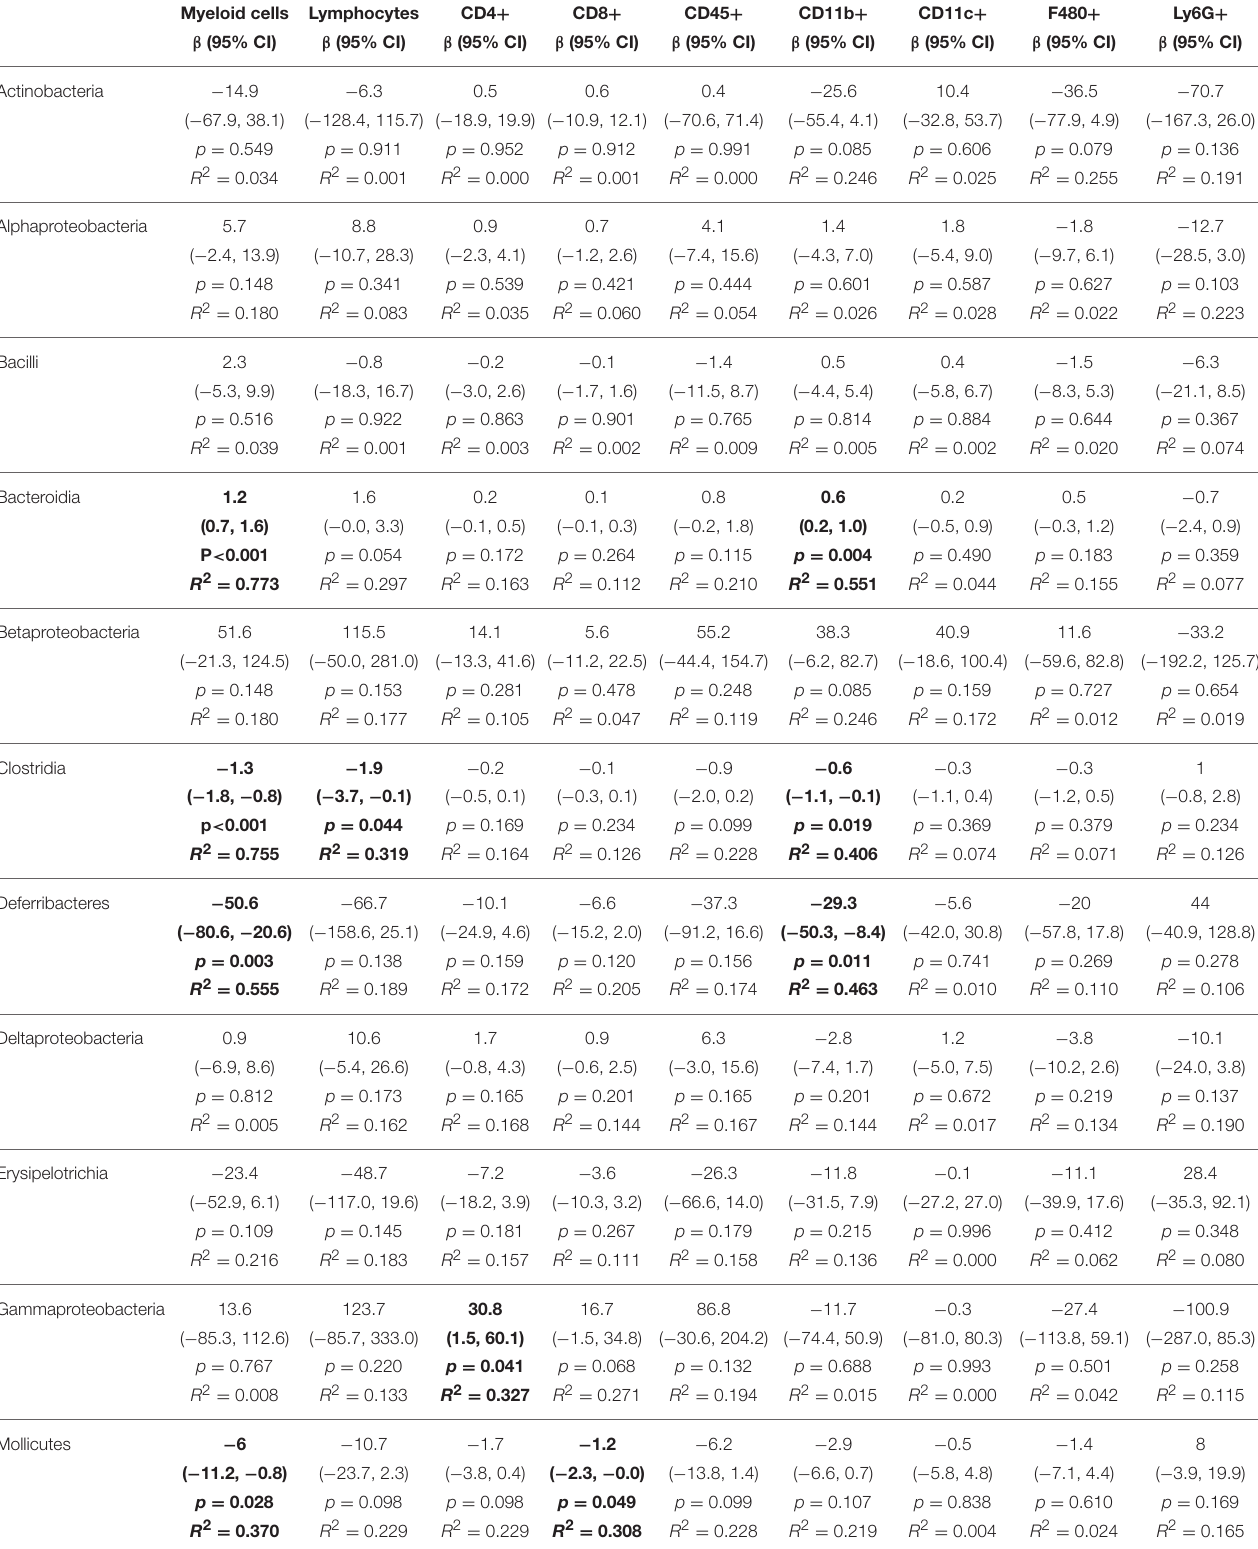
TABLE 4 | Associations from linear regression models between gut microbiota and alterations of adaptive immune system parameters measured in the